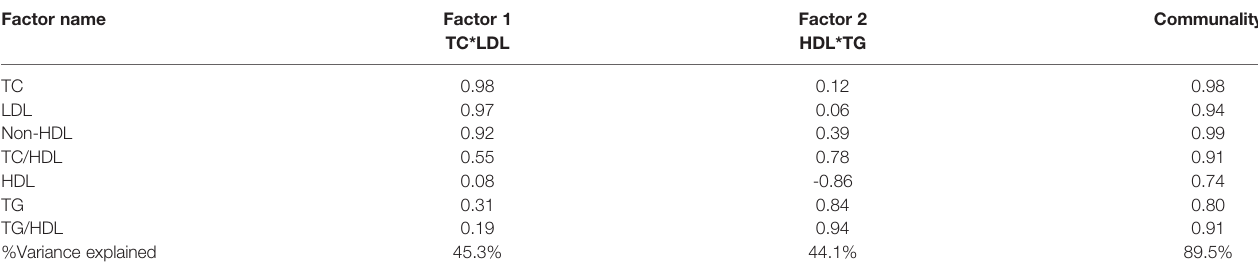
TABLE 2 | Results of factor analysis of lipid parameters and factor loading with varimax rotation after adjusting for age, sex, body mass index and